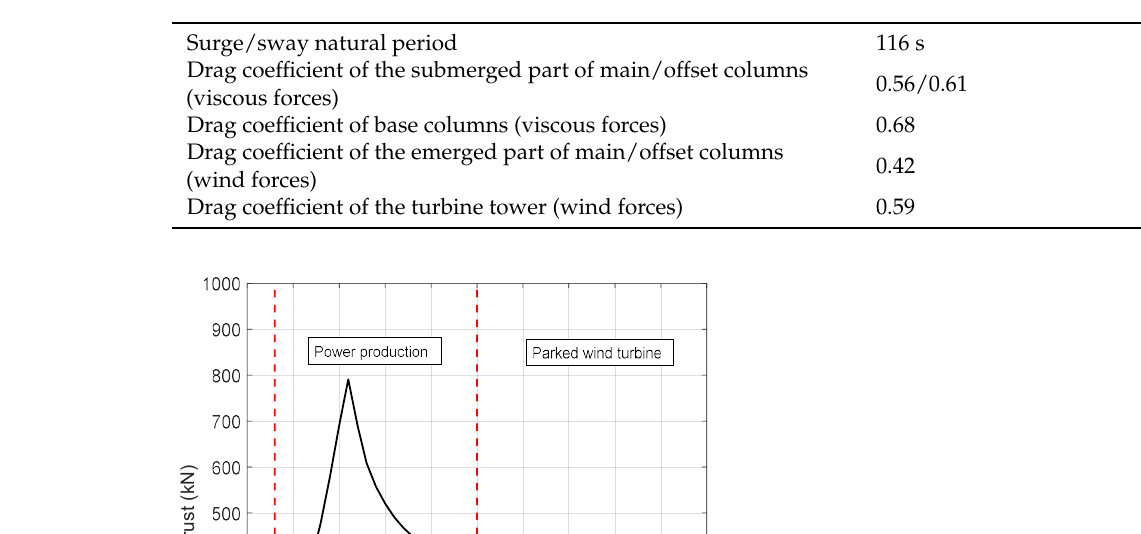
Table 2. Main properties of the reference stationkeeping system.